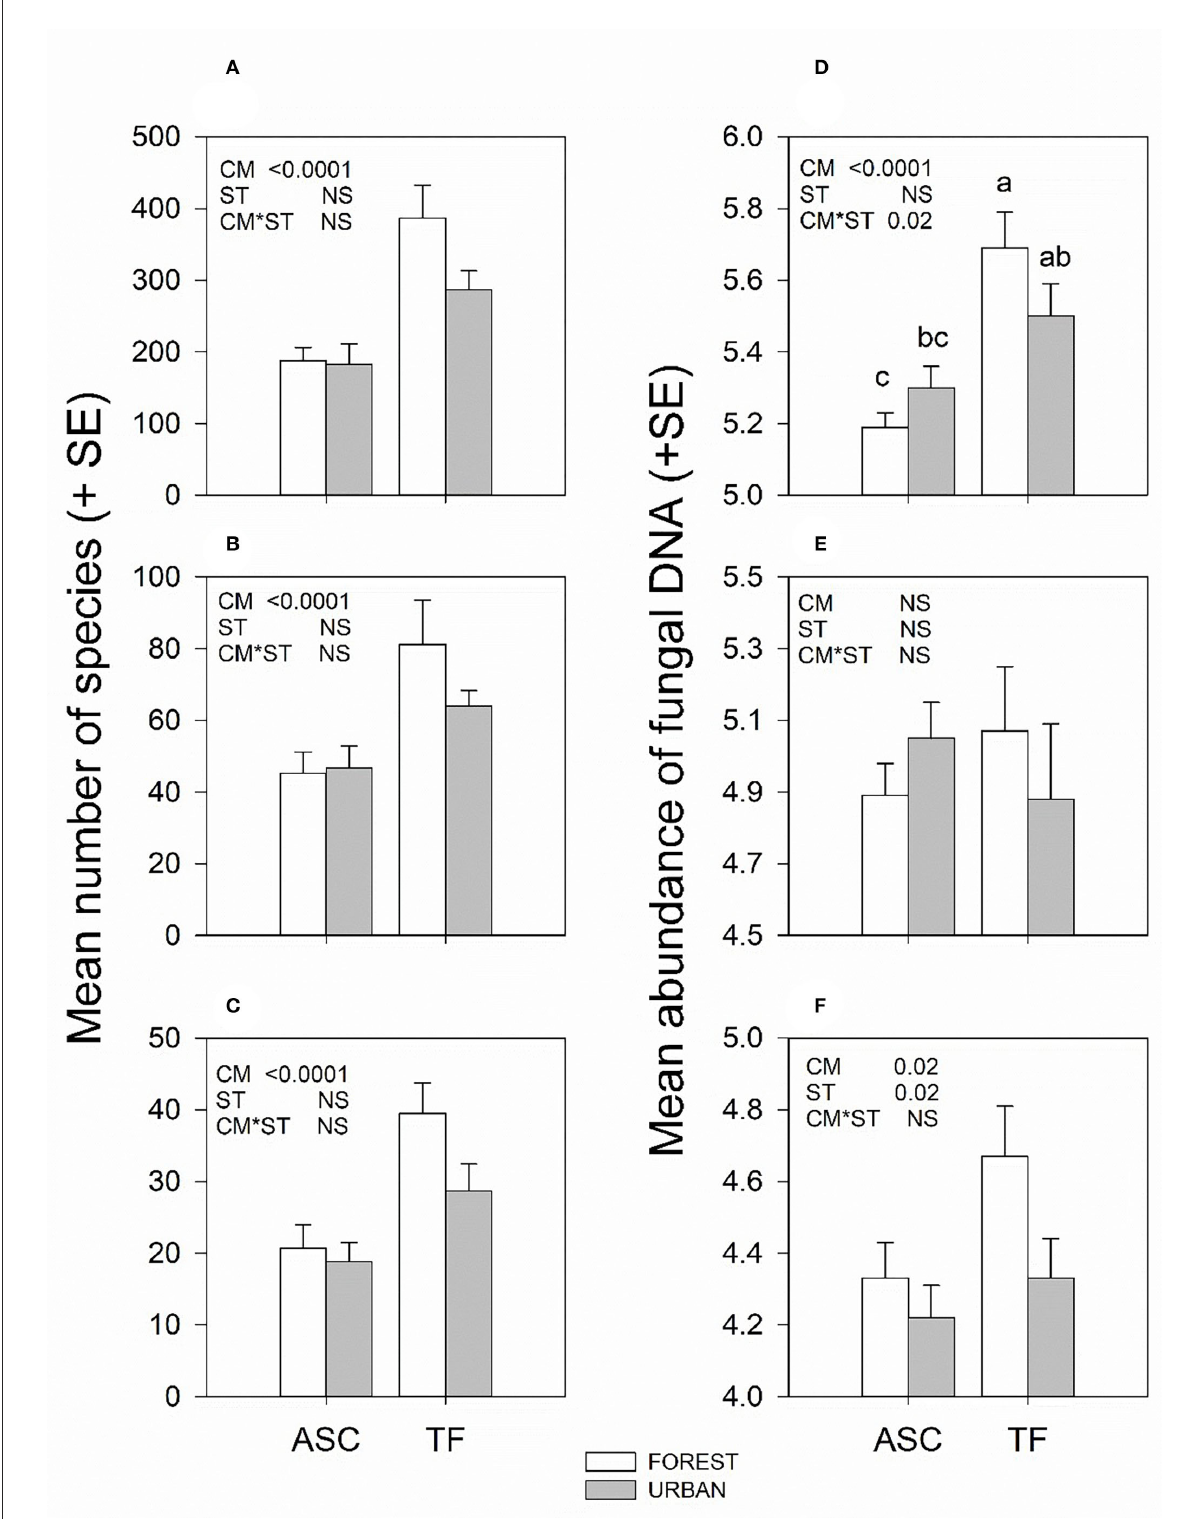
FIGURE2 Mean ( + SE) species richness (A–C) and mean ( + SE) abundance of DNA (D–F) of all fungi (top), plant pathogens (middle), and forest pathogens (bottom) collected by aerial spore collectors (ASC) vs. trap fluids (TF) in forest and urban sites in New Brunswick, Nova Scotia, and Ontario, during a 4-week period in August to September 2018. Significance of collection method (CM), site type (ST), and their interaction (CM*ST) from generalized linear mixed models. Tukey test on least square means was performed only on mean abundance of fungi for collection method-site type combinations (D) due to the significant interaction; means followed by different letters were significantly different ( p ≤